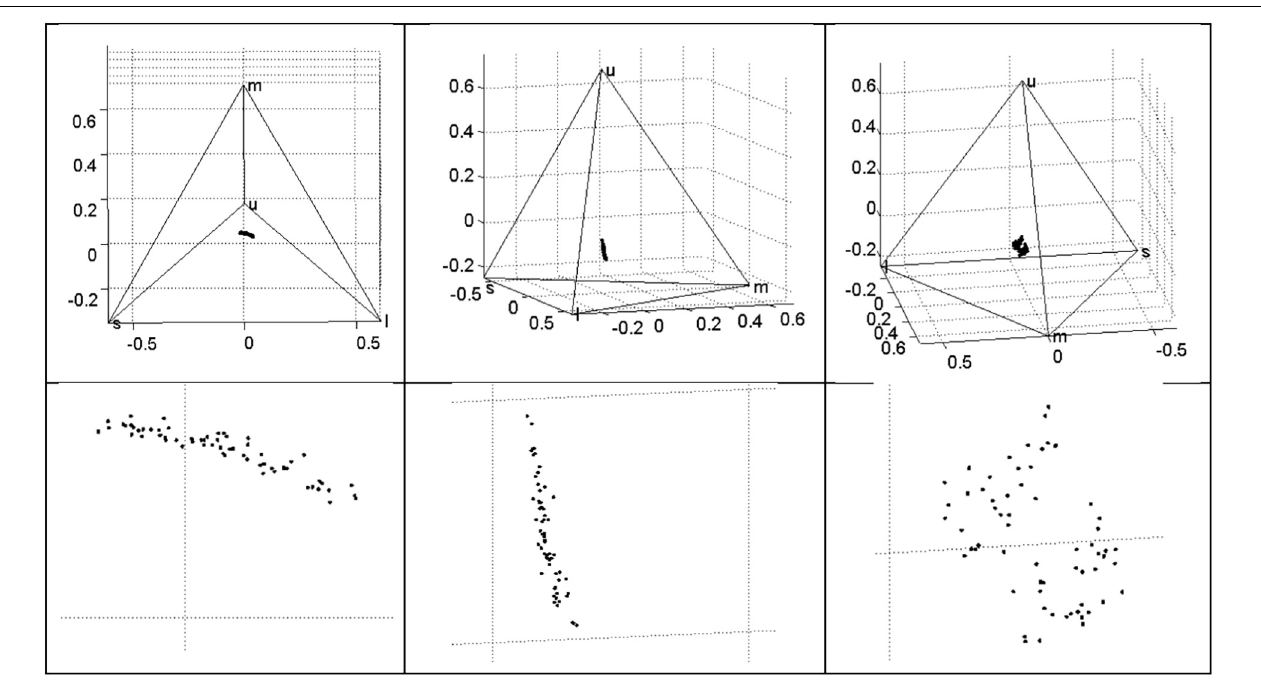
FIGURE 4 | Variation in Rüppell’s weaver eggshell ground color (though influenced to some extent by maculation), in terms of photon catches for an average avian UV-type retina, plotted in tetrahedral space, where each vertex represents a cone type, and where proportional photon catch for a given cone type reaches unity at the vertex. Variation can be characterized as a plane near the achromatic origin (centroid) that varies mostly in the UV axis and the axis between long (red) and short-medium (blue–green) wavelengths. The variation is apparently bimodal ( right panel ).